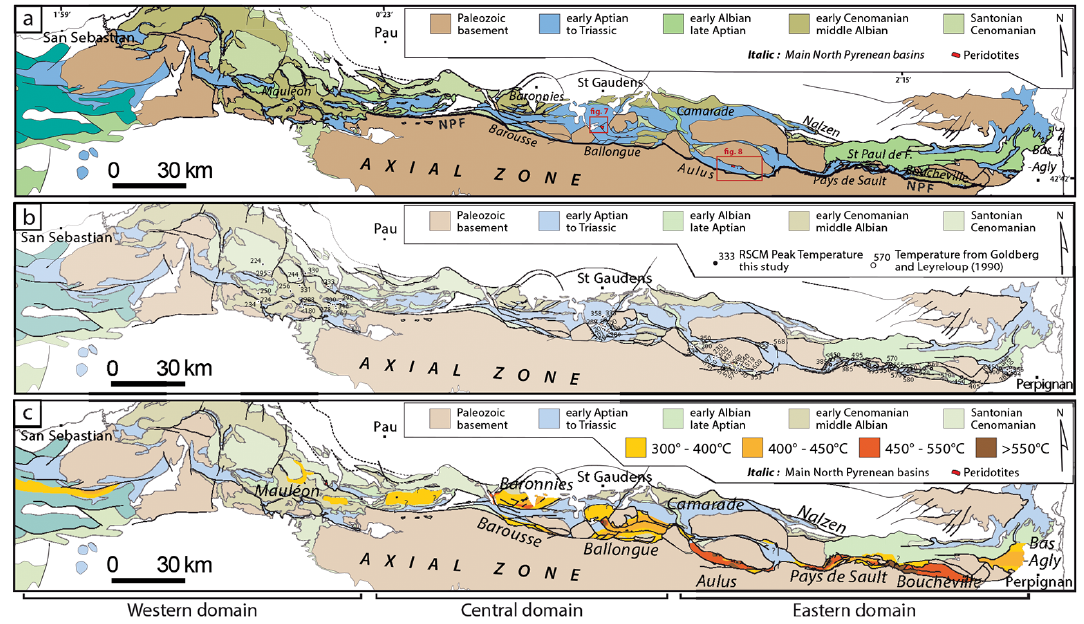
Figure 2. (a) Simplified geological map of the North Pyrenean Zone, compiled from Choukroune and Séguret (1973), Golberg and Leyreloup (1990), Debroas (2003) and Jammes et al. (2009), and from the 1/50000 geological map of the BRGM. (b) Map of peak metamorphic temperatures estimated using RSCM geothermometry (black dots). Only some values are reported on the map. See Table 1 for an exhaustive list and location of all the RSCM data. Temperatures of Golberg and Leyreloup (1990) are also reported for the eastern NPZ (white dots). (c) Map of isometamorphic zones; data compiled are from this study and the literature (Choukroune and Séguret, 1973; Bernus-Maury, 1984; Golberg, 1987; Golberg and Leyreloup,